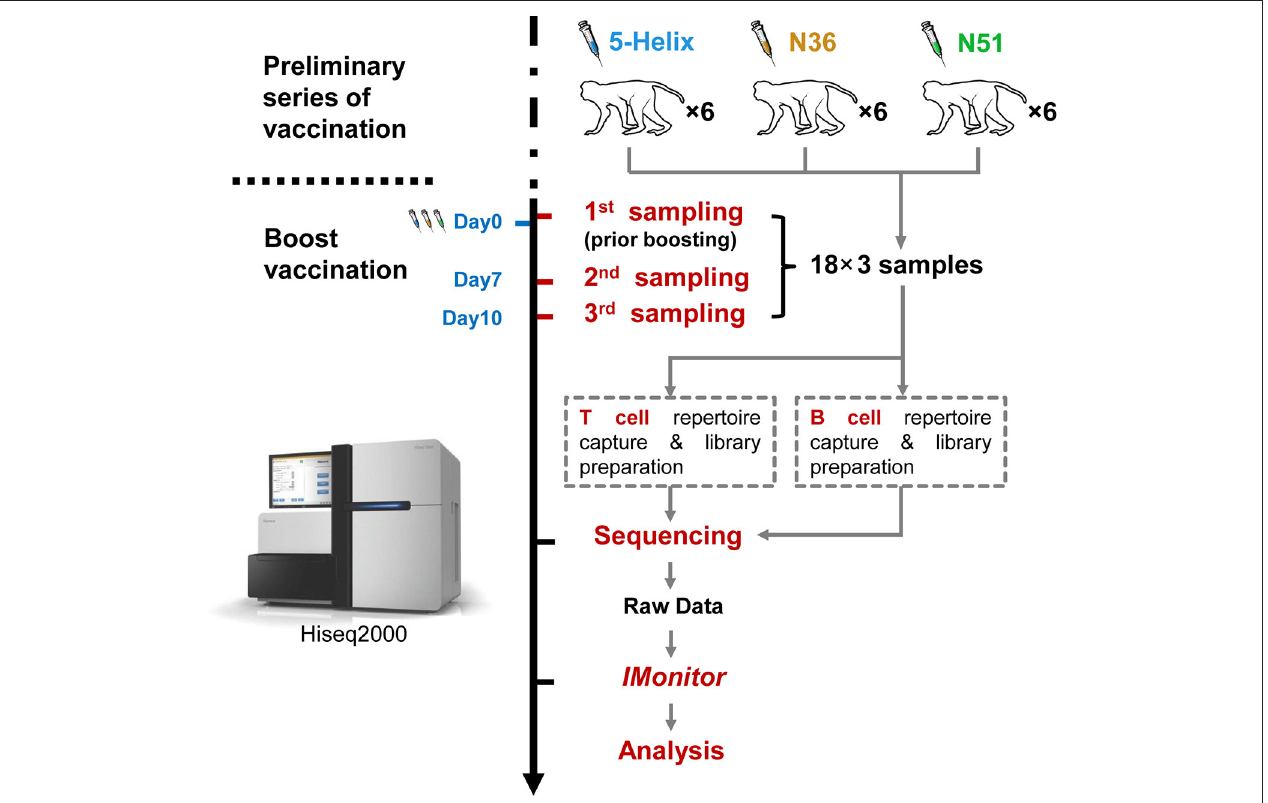
FIGURE 1 | Schema of the work flow used in this study. Eighteen (18) rhesus macaques were divided equally into three groups (5-Helix, N51. and N36) (total 54 samples) and administered with the corresponding vaccines. The vaccination regimen contains the preliminary series of vaccination and the boost vaccination. The 18 macaques were sampled for the first time at Day 0 prior boost. After the boost, the macaques were further sampled at day 7 and 10. Both T and B cell repertoires of the 54 samples were captured, and prepared into 108 sequencing libraries for Illumina Hiseq2000. Raw sequencing data were then subjected to IMonitor work flow for basic TCR and IGH repertoire